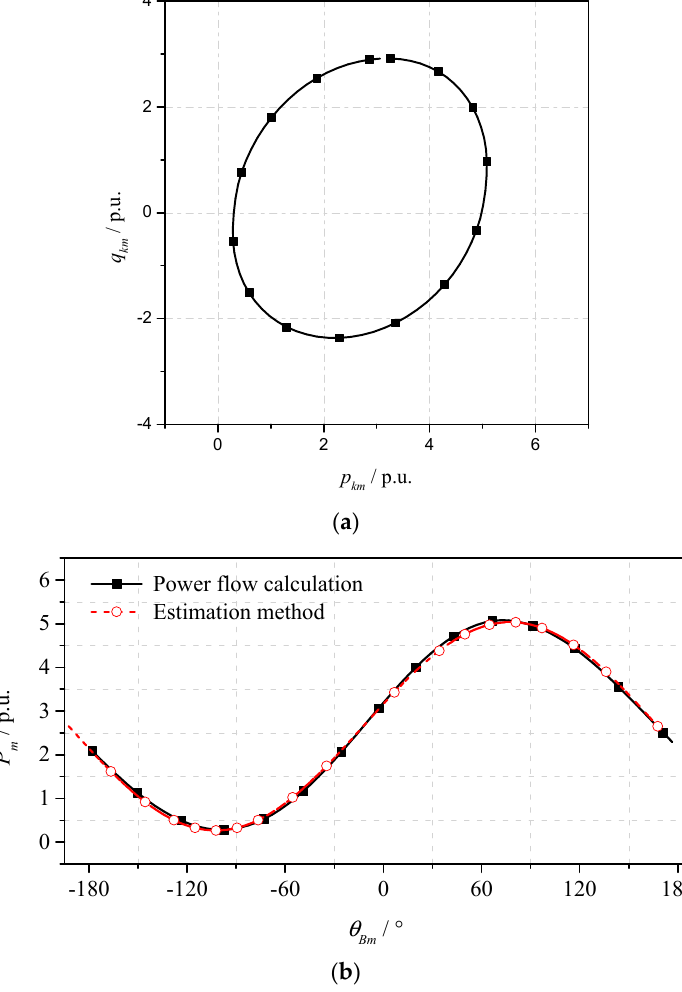
θ km - q km curve; ( b ) Bm - p km